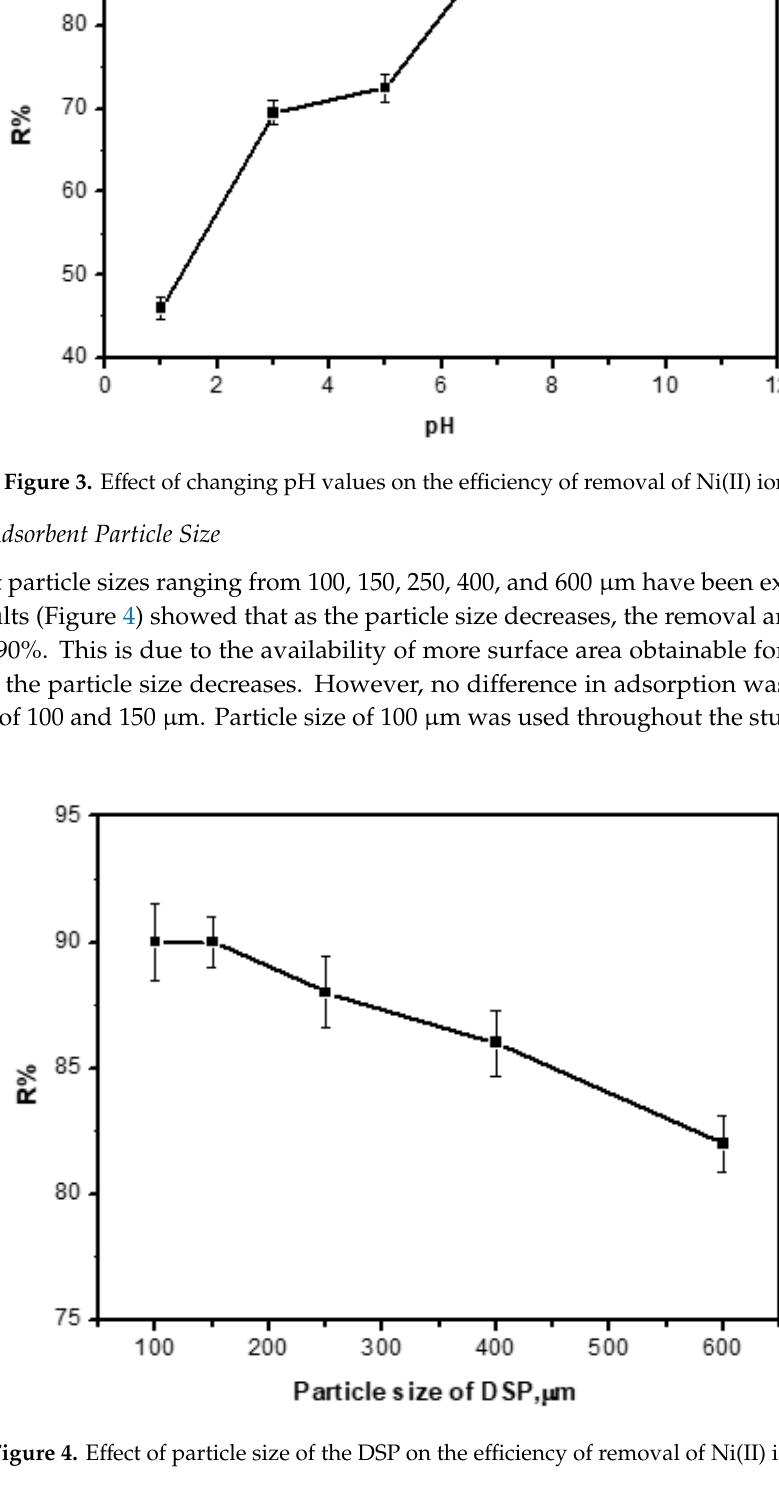
Figure 5. Effect of the DSP mass on the removal efficiency of Ni(II) ions.